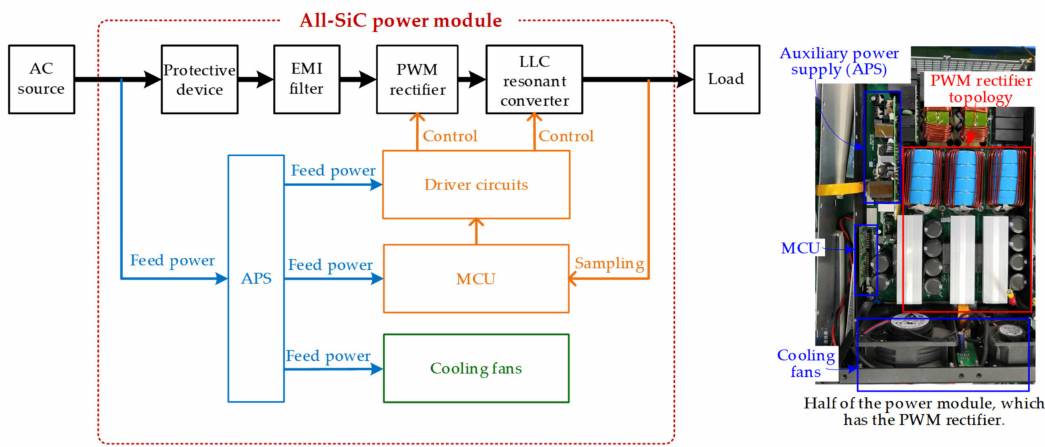
Figure 2. Framework diagram of all-SiC power module system with PWM rectifier inside.